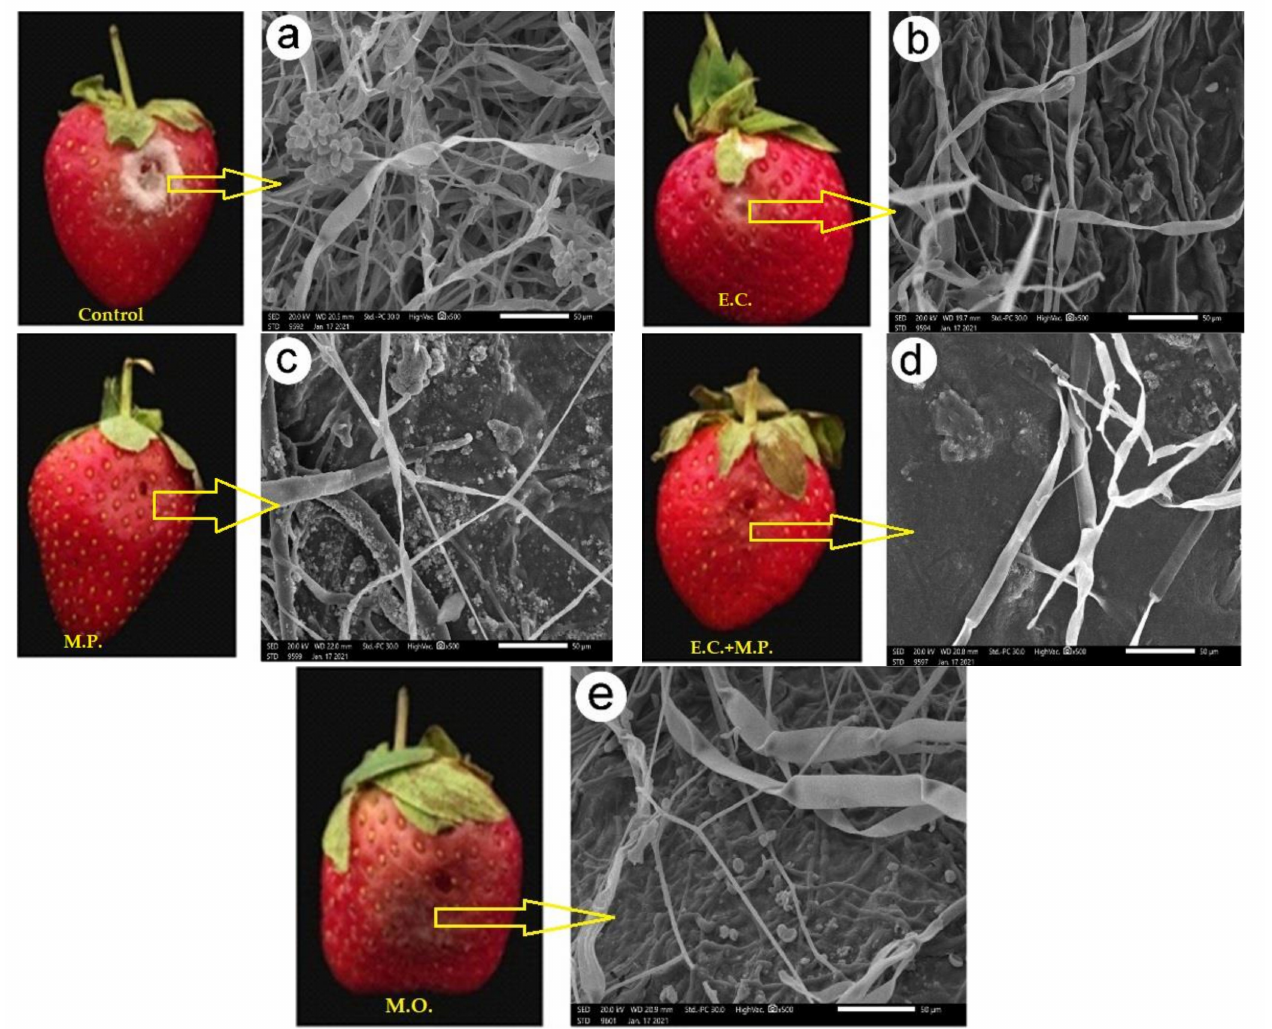
Figure 5. Visual observation and SEM photos of the treated and untreated fruits with oils after 10 days from the fungal inoculation and storage at 5 ◦ C. ( a ) Untreated fruits and treated fruits with ( b ) E. camaldulensis var obtusa EO, ( c ) M. piperita EO, ( d ) mixture of E. camaldulensis var obtusa and M. piperita EOs (1/1 v / v ) and ( e ) M. oleifera